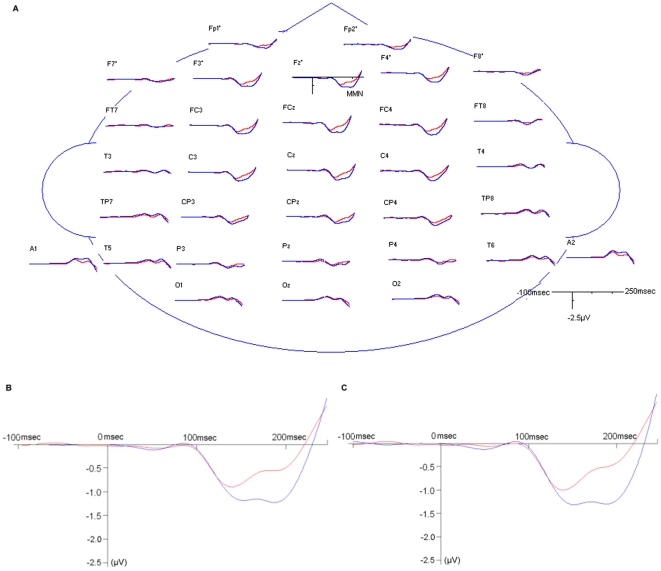
Grand average mismatch negativity waveforms.(A) Grand average mismatch negativity waveform at each electrode shown for schizophrenia patients (red line) and healthy subjects (blue line). The mismatch negativity waveform reversed in polarity at the mastoid electrodes. (B) Grand average MMN waveform at electrode Fz. (C) Grand average MMN waveform at electrode FCz.